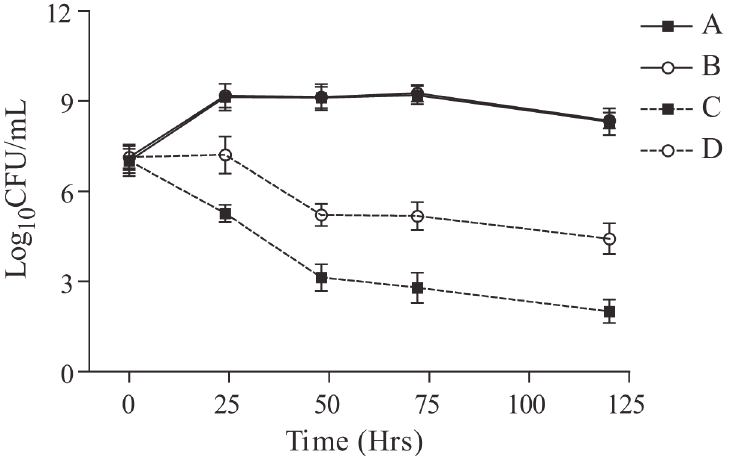
Figure 2. Effect of drought on the survival of P. putida NBRI1108 and NBRI1108T. Treatments are designated as (A) NBRI1108 without PEG6000, (B) NBRI1108T without PEG6000, (C) NBRI1108 with 45% PEG6000 and (D) NBRI1108T with 45% PEG6000. Values are the mean ± SE of three samples.